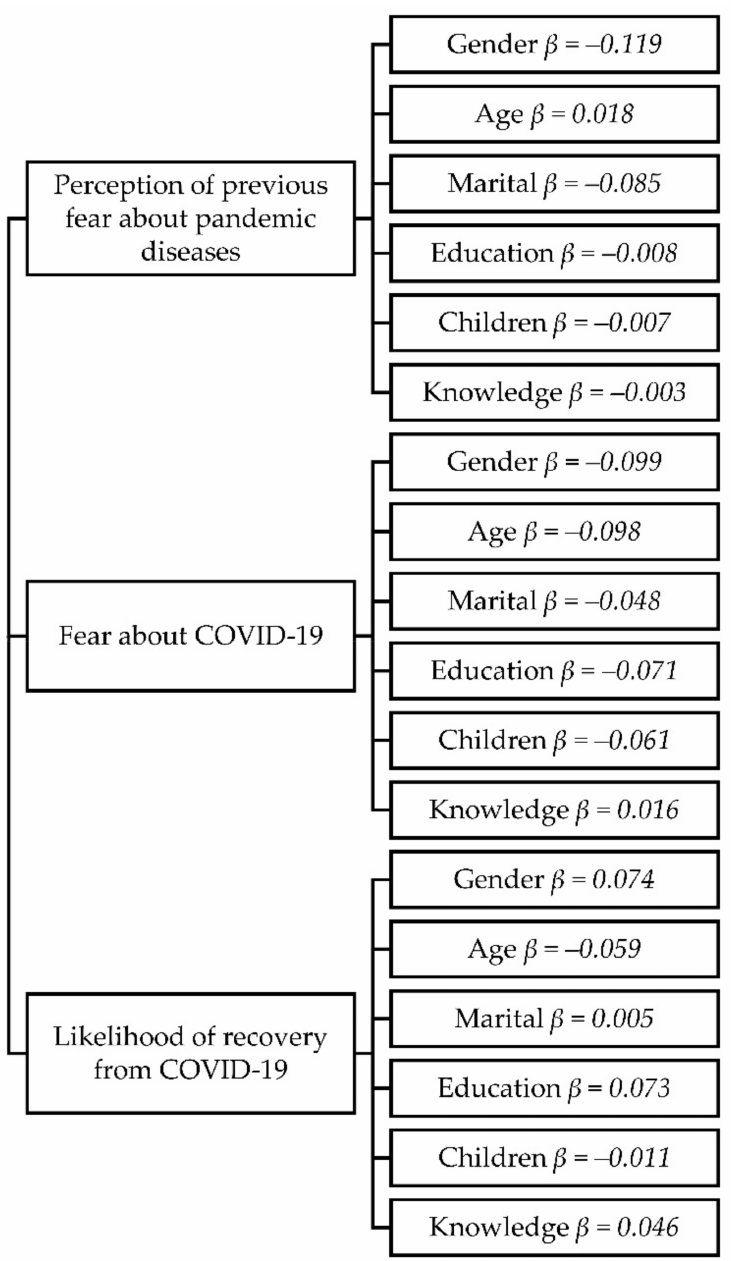
Figure 3. The predictors of coronavirus disease